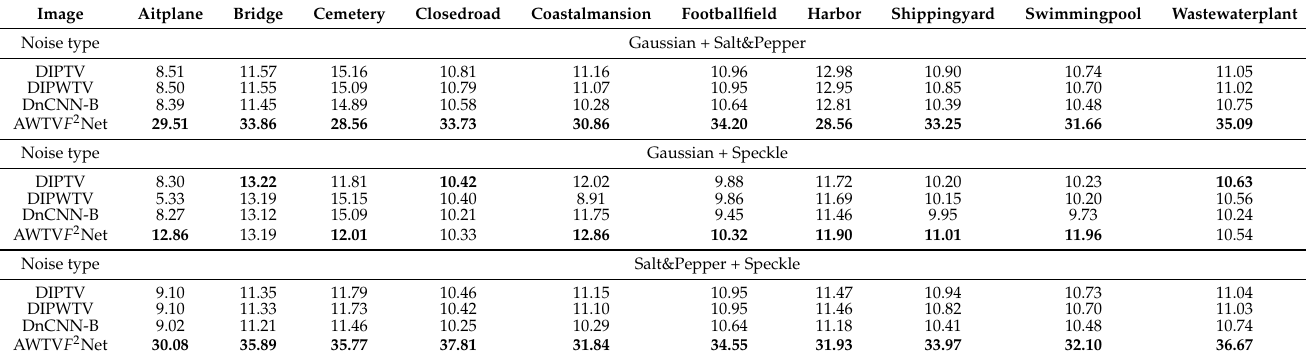
Table 7. PSNR results of different methods on the PatternNet dataset. The bold values denote the best results.